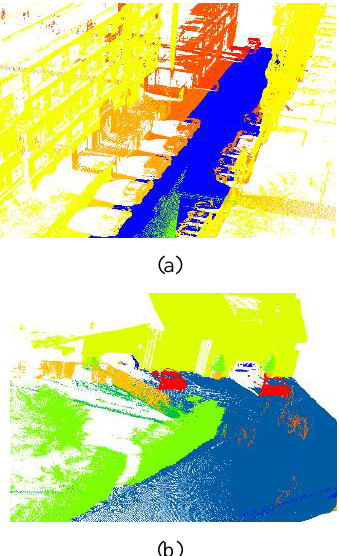
Figure 3. Our tested dataset benchmark. (a) Cassette from IQTM dataset (Vallet et al., 2015), (b) Station from Semantic 3D dataset (Hackel et al., 2017).